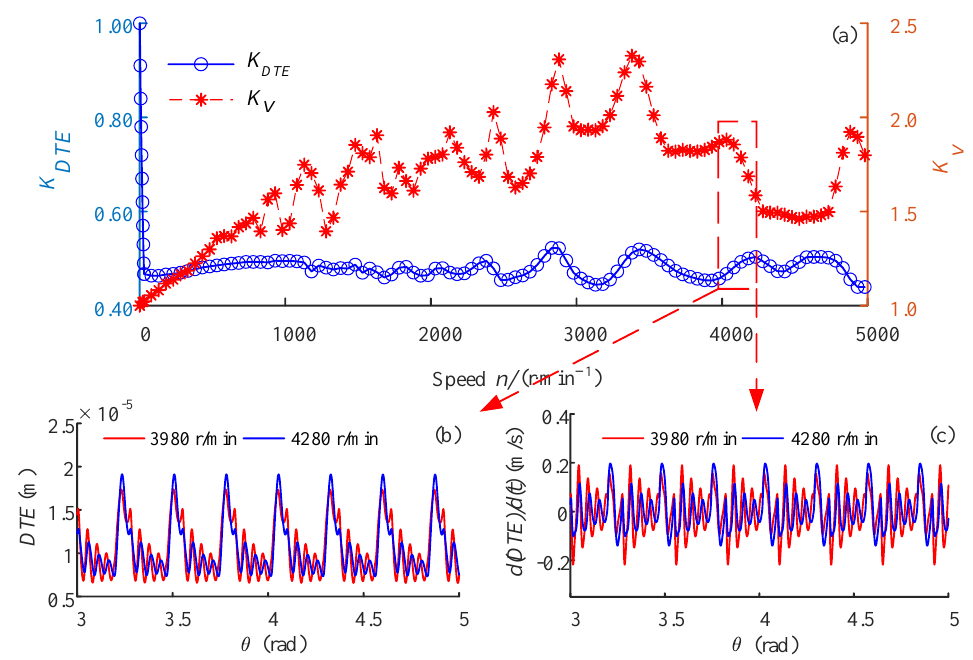
Figure 11. Relations between K v and K DTE for epoxy gear pair: ( a ) comparison K v of K DTE ; ( b ) DTEs; ( c ) derivative of DTEs.